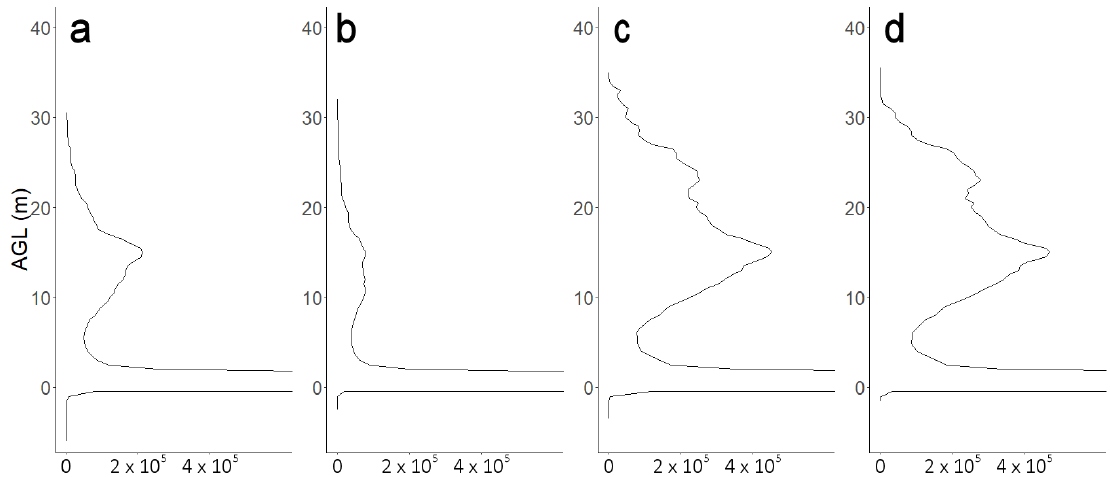
Figure 8. Dense point cloud frequency plots at 0.5 m bin widths for ( a ) red, ( b ) green, ( c ) red edge, and ( d ) NIR. Point frequencies less than 2 m have been cropped to improve the interpretation of reconstructed points more than 2 m